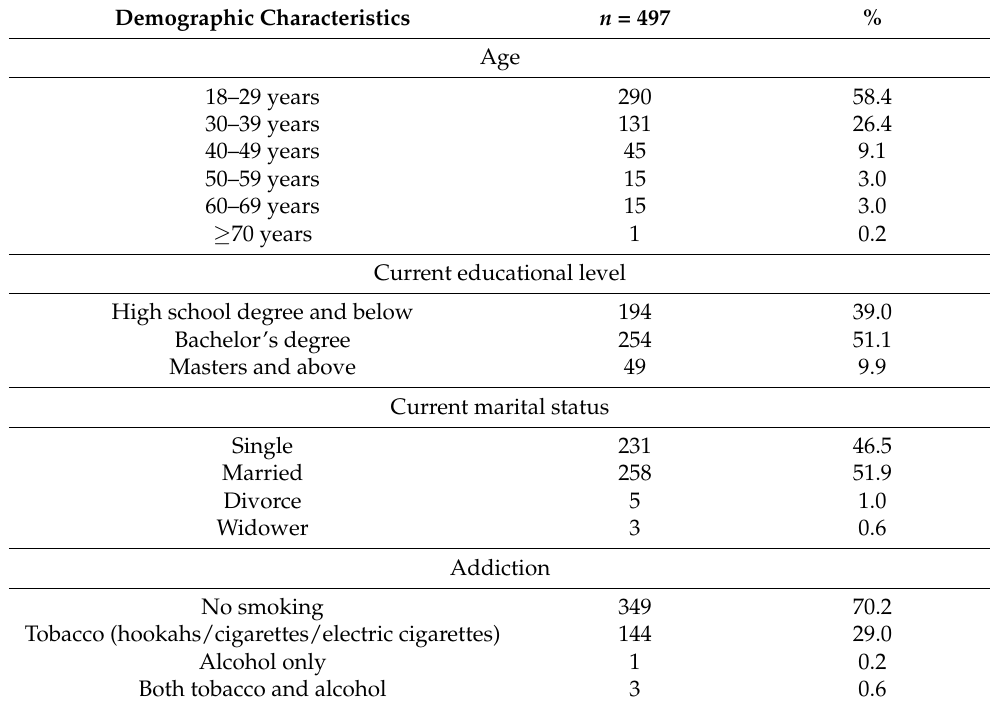
Table 1. Participants’ demographic characteristics ( n = 497).